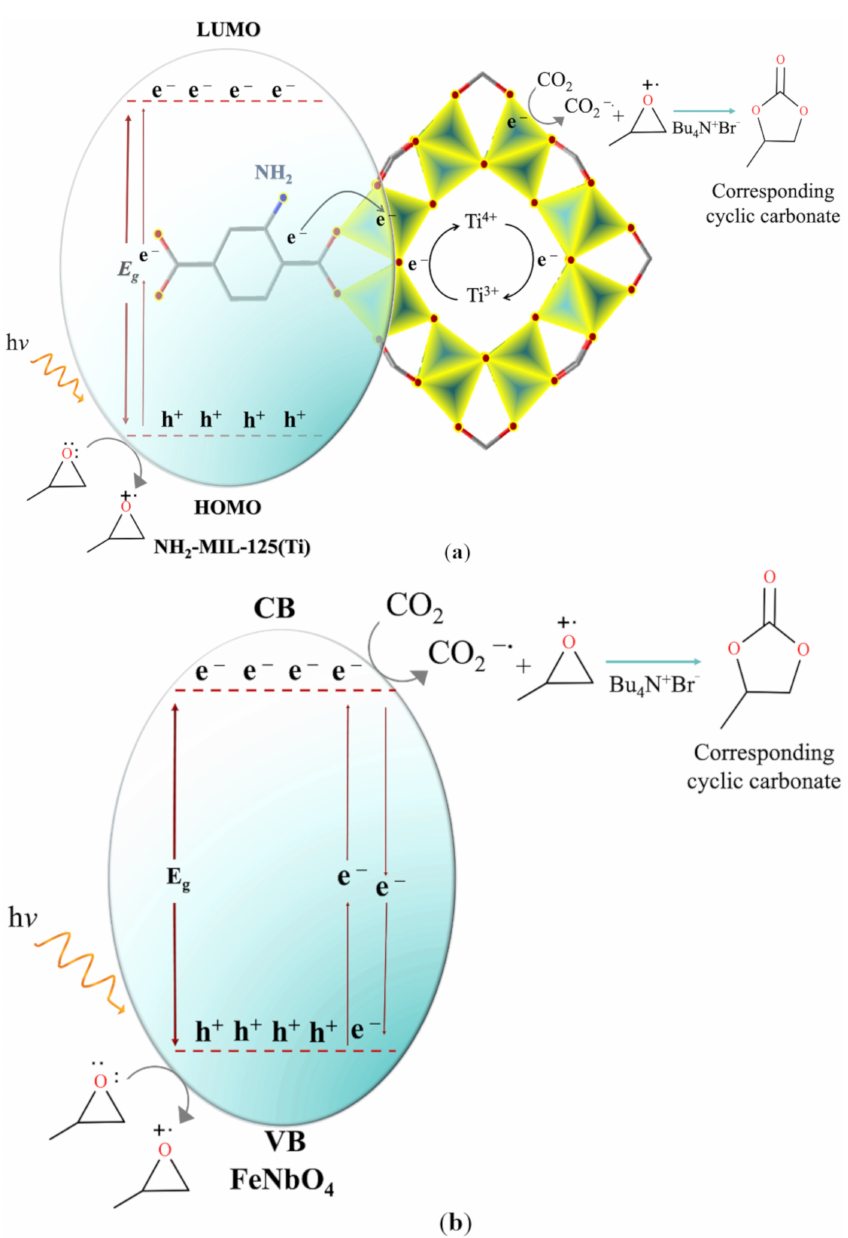
Figure 7. Proposed mechanism of ( a ) NH 2 -MIL-125(Ti) and ( b ) FeNbO 4 for the photocatalytic addition of CO 2 into propylene